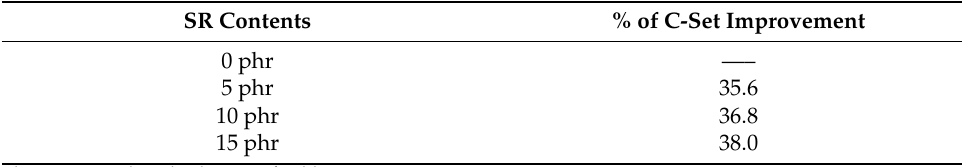
Figure 4. Compression set of SR/EPDM composites with varying SR contents. Table 2. Compression set values of SR/EPDM composites.